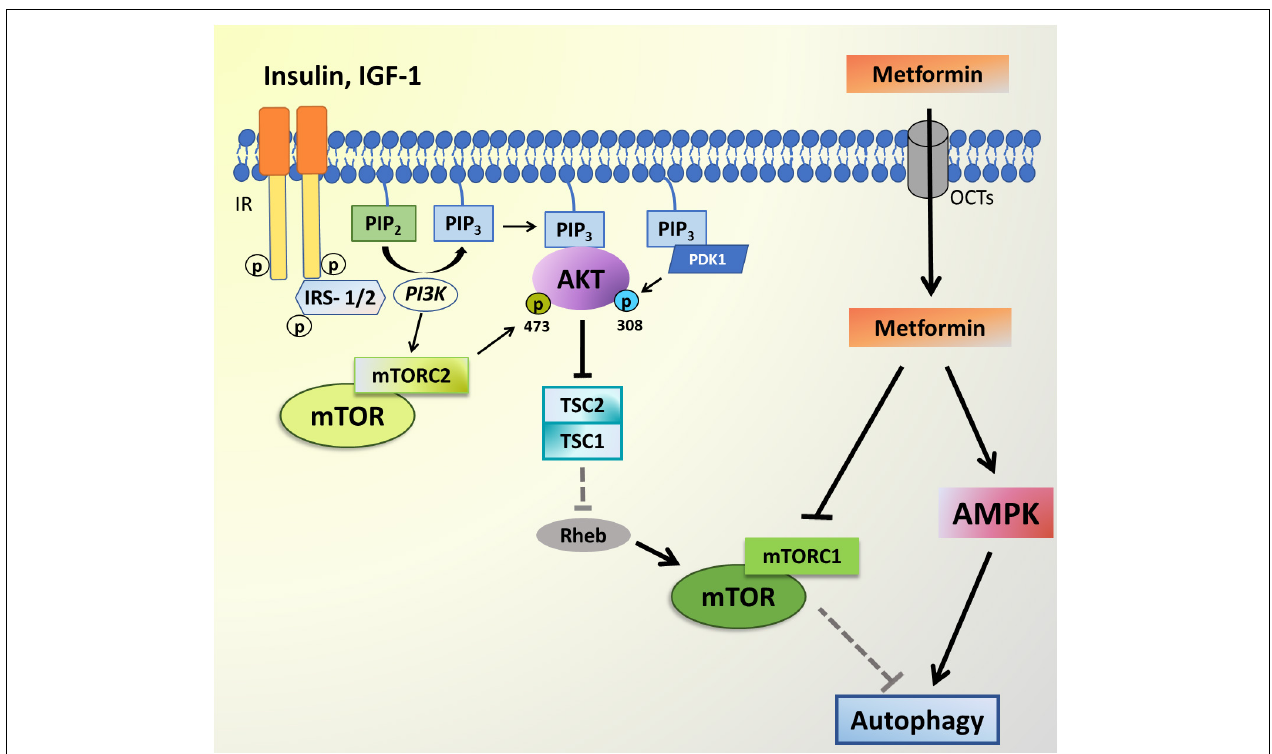
FIGURE 2 | PI3K-AKT-mTOR signaling and Metformin targets. The AKT signaling pathway can be triggered by insulin-like growth factor 1 (IGF-1) and insulin, which bind to transmembrane receptors tirosine kinase (RTK) leading to IRS-1/2 phosphorylation, PI3K activation and subsequent phosphatidylinositol-4,5-bisphosphate (PIP 2 ) to phosphatidylinositol-3,4,5-trisphosphate (PIP 3 ) conversion. AKT and PDK1 bind to PIP 3 at the plasma membrane, and PDK1 phosphorylates the activation loop of AKT at T308. RTK signaling also activates mTOR complex 2 (mTORC2) through an unknown mechanism, and mTORC2 phosphorylates AKT on S473. Active AKT is responsible for the inhibition of negative regulators of mTOR, such as tuberous sclerosis complex (TSC1/2), which induces the mTOR activator Rheb, thereby releasing the mTOR complex to phosphorylate its targets. mTORC1 activity inhibits autophagy. The Metformin enters the cell through organic cation transporters (OCTs) and is able to inhibit mTORC1 complex, while also activating AMPK thus leading to autophagy